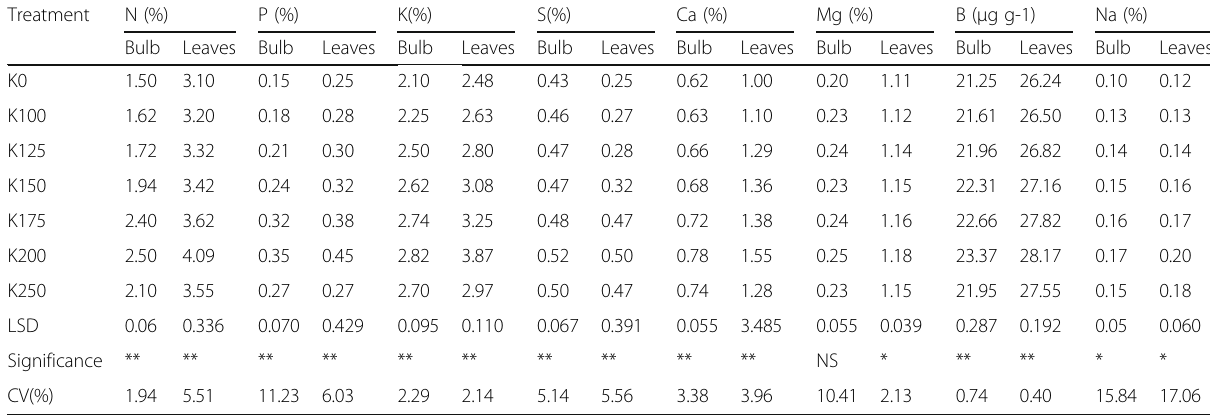
Table 3 Effect of different levels of K on N, P, K, S, Ca, Mg, B, and Na contents in bulb and leaves of garlic